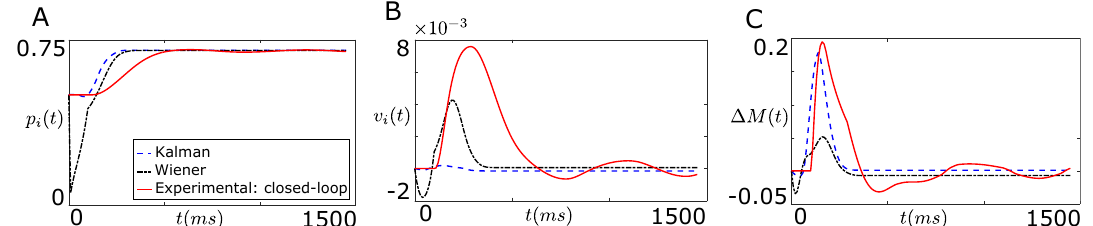
Figure 5. Comparison of the open-loop performances of the Wiener filter based decoder and the Kalman filter based decoder with the performance of the closed-loop real system shown in Figure 2.